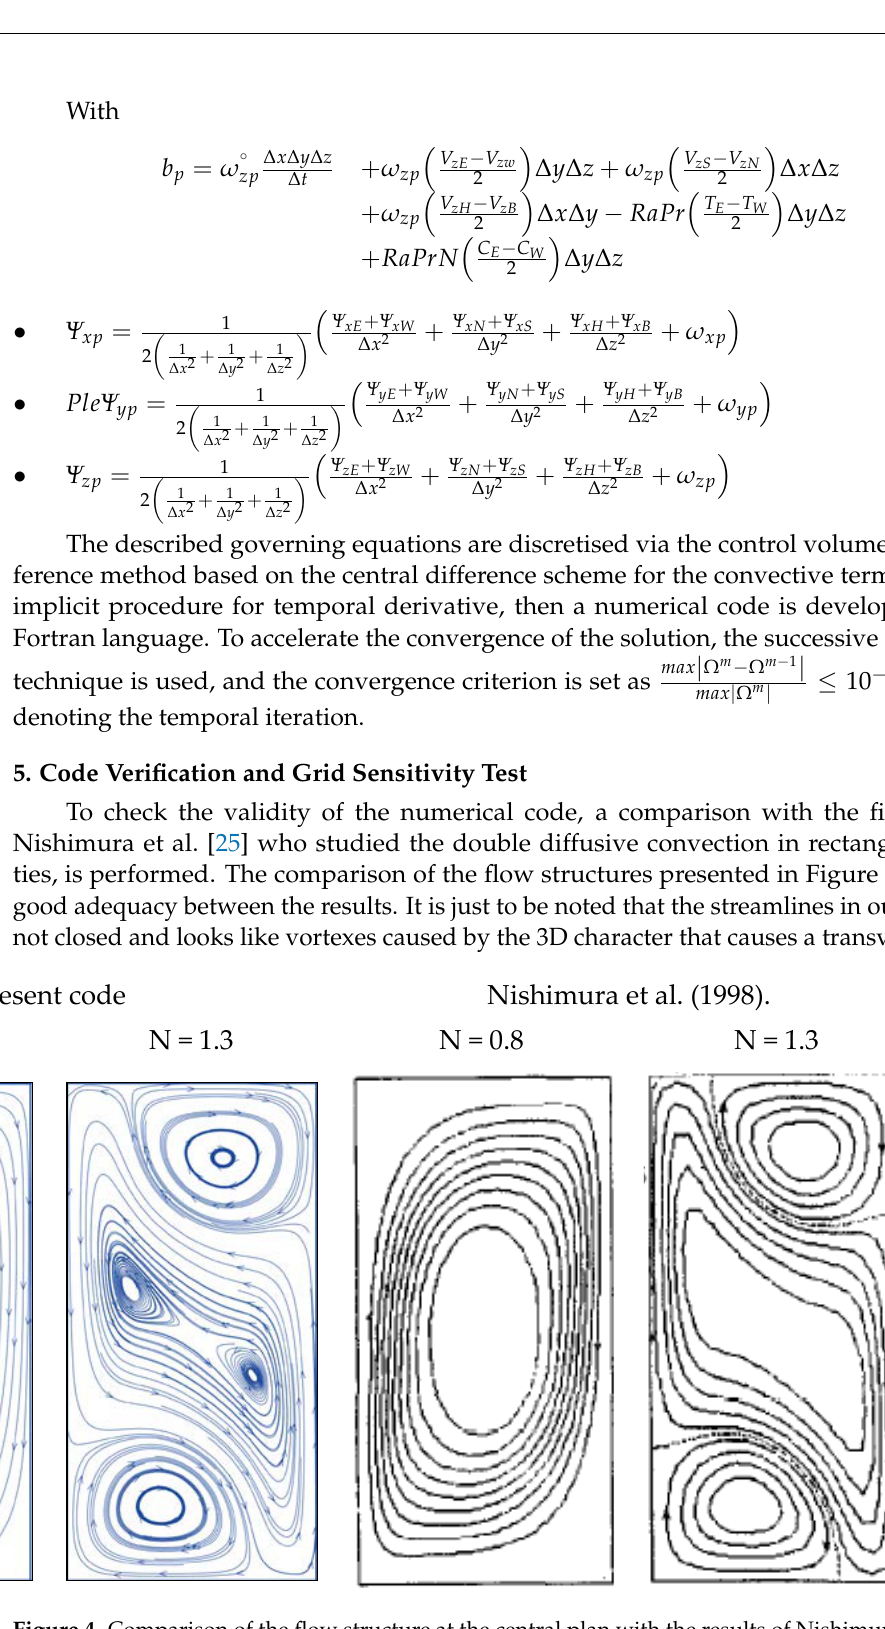
Figure 4. Comparison of the flow structure at the central plan with the results of Nishimura et al. [25] for Ra = 10 5 , Le = 2 and Pr = 1.